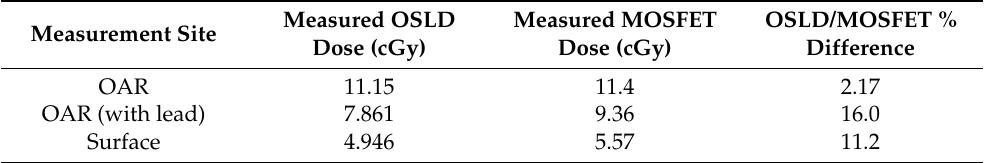
Table 6. Valencia OAR and surface measurements. OAR and surface dose measurements with H3 Valencia. A dose of 600 cGy was delivered to the